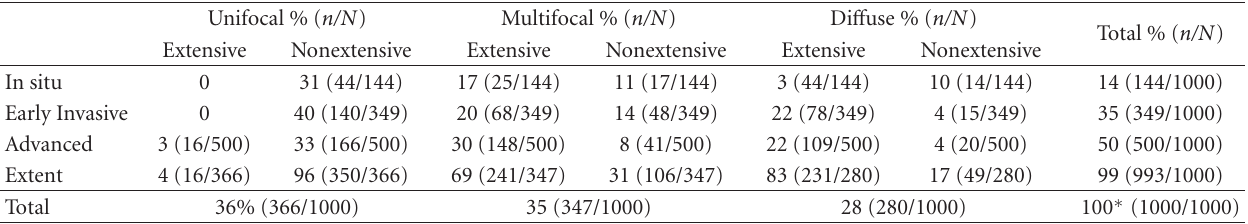
Table 1: 1000 consecutive breast cancer cases by focality, disease extent, and stage. Falun, Dec 2007 to Jun 2012. Unifocal % ( n/N